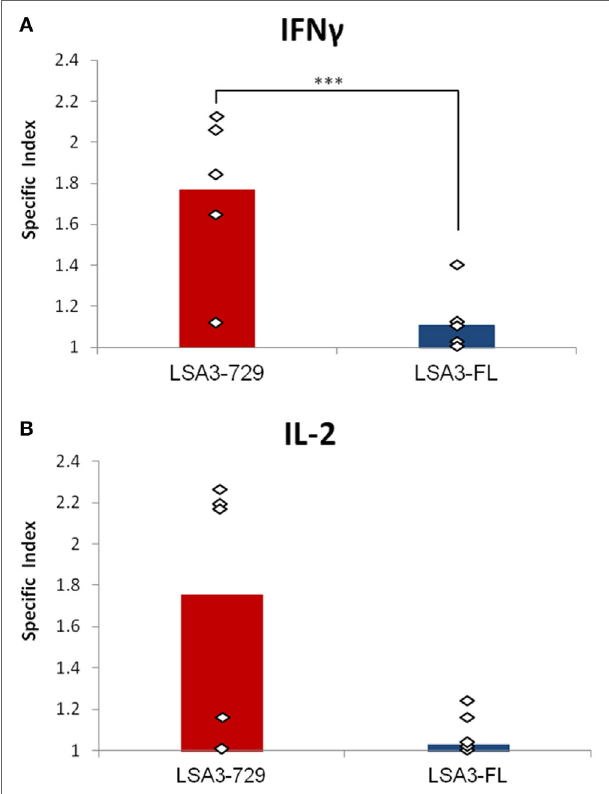
FigUre 3 | T cell-dependent IFN- γ and IL-2 responses elicited by liver stage antigen 3-full length (LSA3-FL) and liver stage antigen 3-729 (short form) (LSA3-729). NSG mice were engrafted with in vitro primed human spleen cells obtained from five different donors. The humanized-spleen cells-NOD- SCID-gamma null mice were immunized with LSA3-FL or LSA3-729 antigen at days 7 and 21. At day 28, spleen cells of each group of mice were recovered, pooled and cultured in vitro with or without antigen stimulation. Human IFN- γ (a) or IL-2 (b) production was measured by enzyme-linked immunospot. The specific index is the ratio of spot forming cells (SFC) of antigen stimulated cells over SFC of non stimulated cells. Data are presented as mean values of the results obtained with each immunizing antigen using human spleen cells from five different donors. Each dot corresponds to the result obtained with spleen cells pooled from mice of one experimental group. Statistically significant difference is indicated when applicable: p = 0.016 (***).